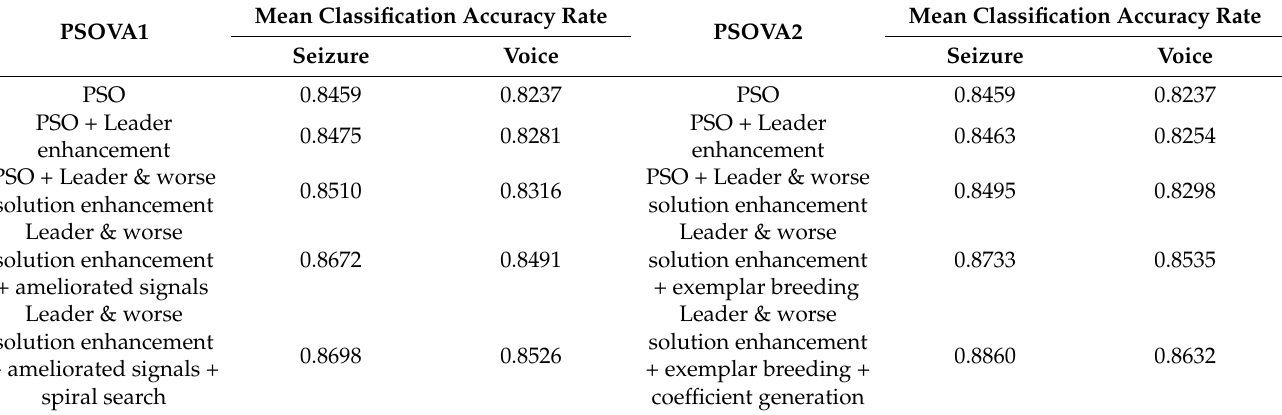
Table 10. The mean classification accuracy rates over 30 runs for the mechanisms in PSOVA1 and PSOVA2 using the Seizure and Voice data